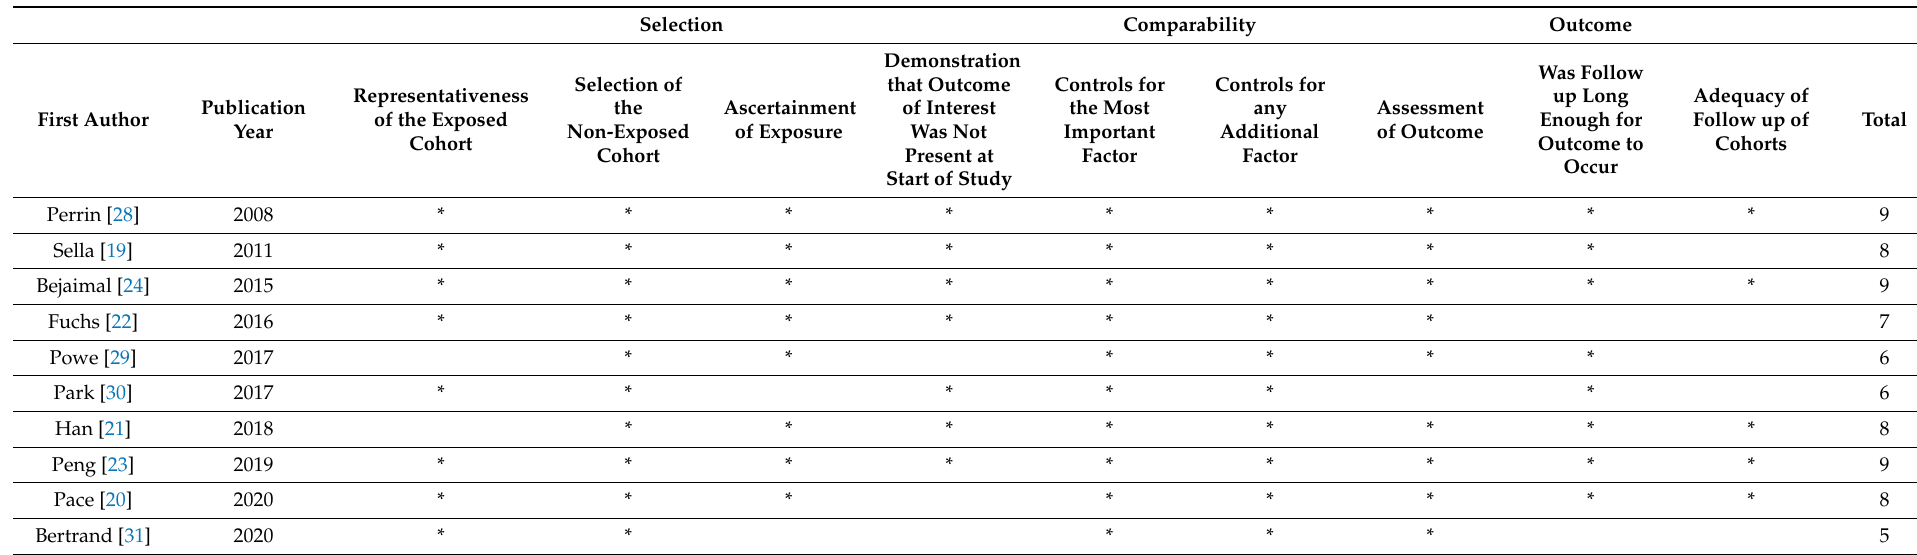
Table 3. Risk of bias and quality assessment of cohort studies.